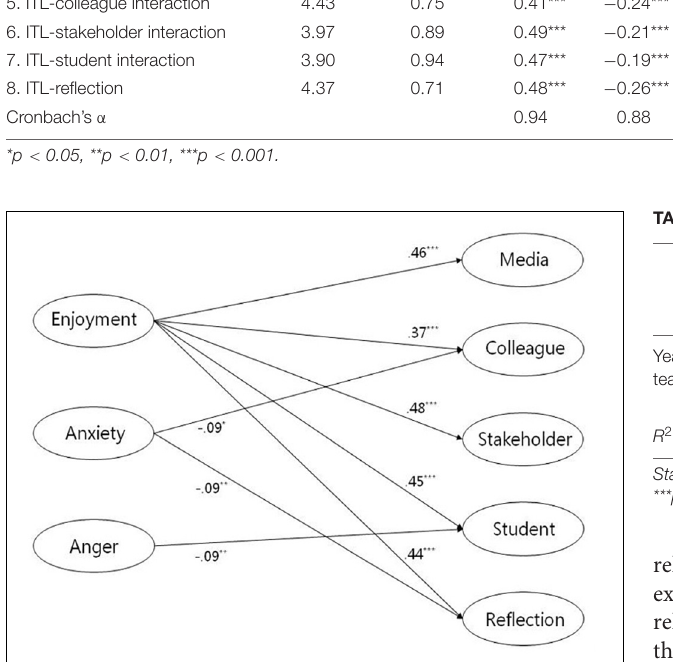
FIGURE 1 | Structural equation model for the relationship between teacher emotions and ITL activities. Manifest indicator intercepts and errors as well as non-significant regression paths are not shown. Standardized regression coefficients are reported. * p < 0.05, ** p < 0.01, *** p < 0.001.